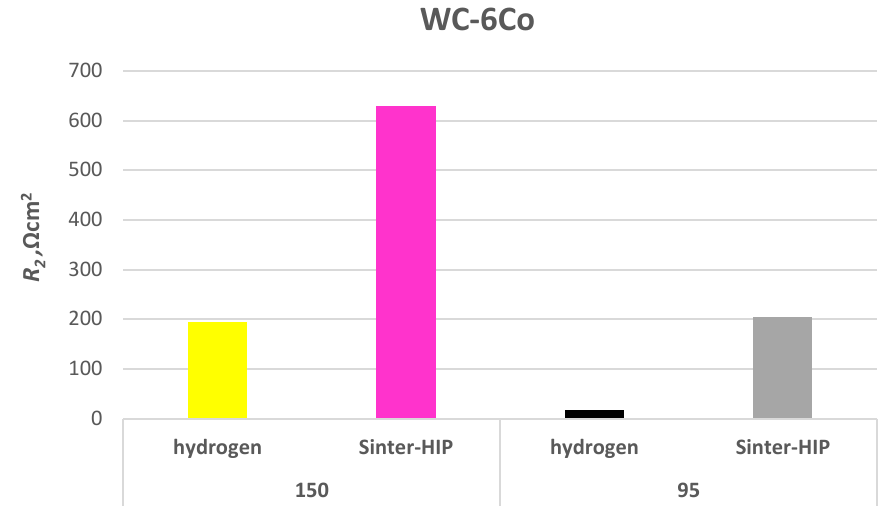
Figure 8. Graphical presentation of the oxide layer resistance.